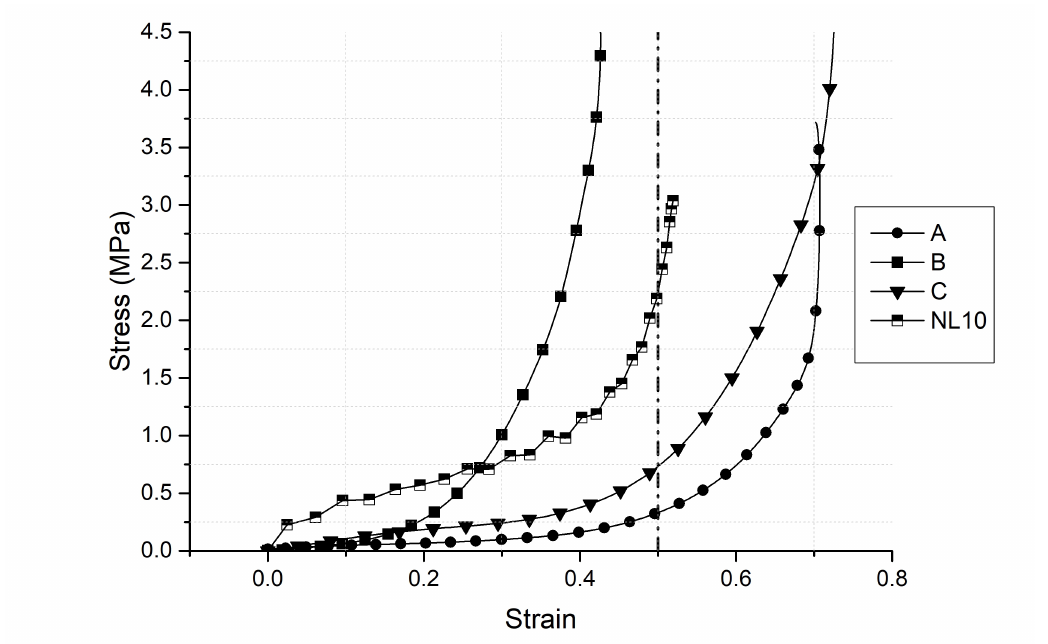
Figure 4. Stress-strain curves from dynamic compression